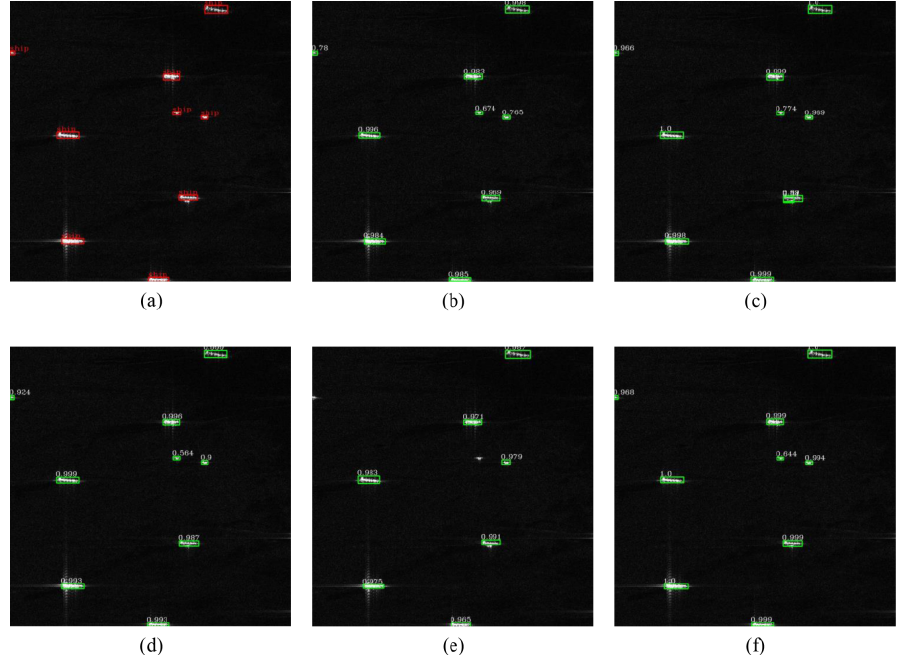
Figure 11. Comparison of detection results for different methods in the offshore scenes of the HRSID. ( a ) Ground-truth objects. ( b ) Detection results of the Faster R-CNN. ( c ) Detection results of the Double-Head R-CNN. ( d ) Detection results of the PANet. ( e ) Detection results of the RetinaNet. ( f ) Detection results of the ASAFE. Green bounding boxes denote the detection results. Red bounding boxes denote the ground-truth